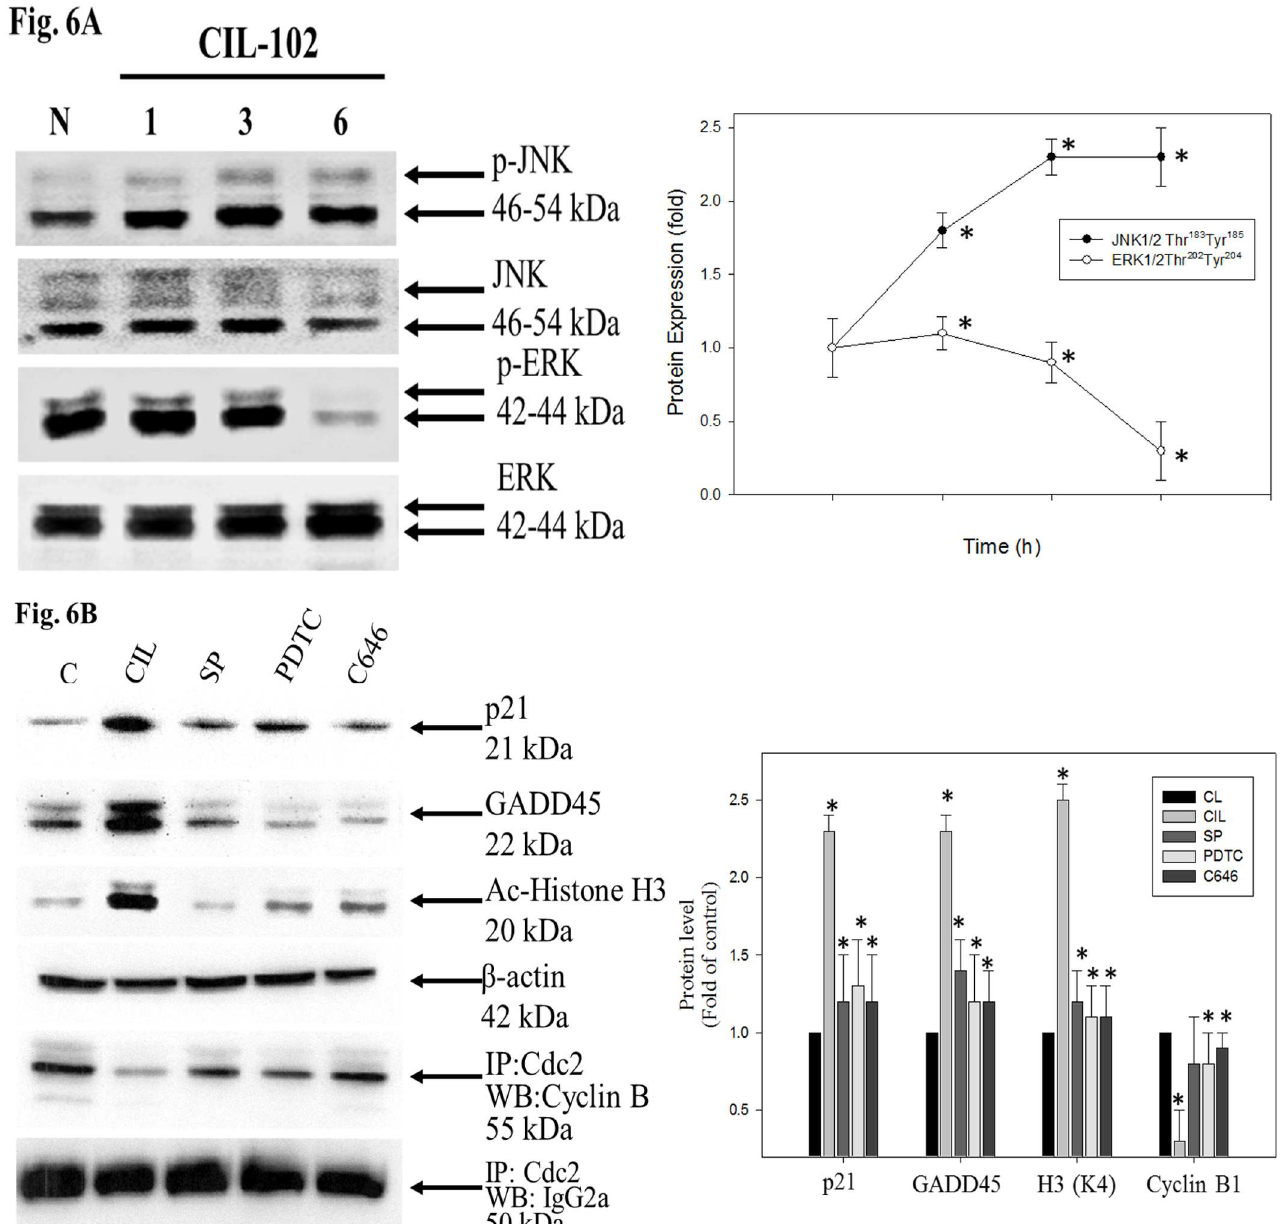
Fig 6. Effect of the kinase inhibitors in blocking CIL-102-induced cell cycle G2/M arrestand apoptosis-related protein. (A) The expression levels of phosphorylation and protein levels of JNK and ERK, after treatment with CIL-102. DLD-1 cells were treated with CIL-102for the indicated time points. Total cell lysates were analyzedby SDS-PAGE and subsequently immunoblotted with antisera. (B) DLD-1 were incubatedwith various concentrations of the specific JNK1/2 inhibitorSP600125,NF κ B inhibitorPDTI or the p300/CREB-BindingProtein inhibitorC646 for 1 h. Next, the cells were treated with CIL-102 for 12 h. Total cell lysates of cells treated with or without CIL-102 for the indicatedtime were extracted, and the expressionof p21, GADD45, p50 NF κ B, Histone H3 (K4) as well as The association of cdc2 with CyclinB were determined, as describedin “Materials and methods”. Protein levels were quantified by densitometric analysiswith the ratio of untreatedcontrol being set 1 fold. The quantitative data were presented as the mean of three repeats from one independent experiment. The data were presentedas mean ± SD of three independent experiments. * P < 0.05,comparedto the control